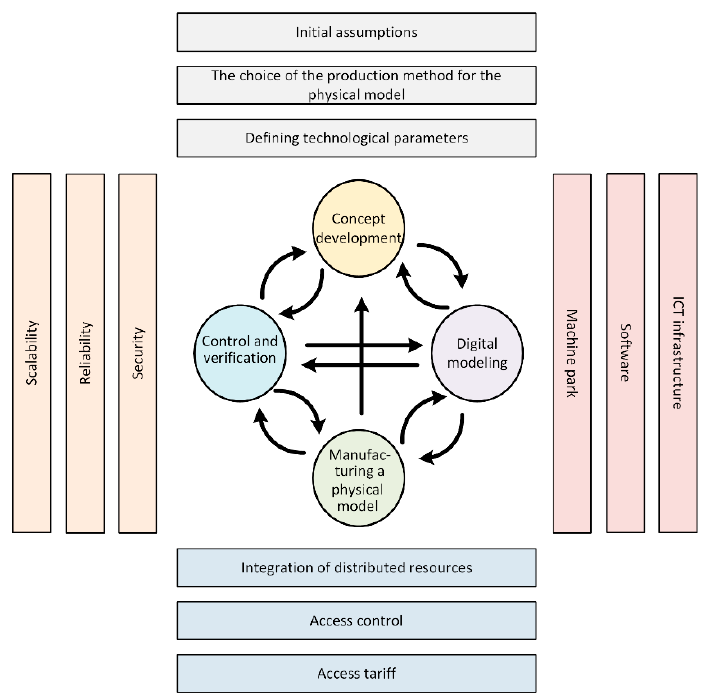
Figure 2. The adopted model of remote and distributed prototyping system.